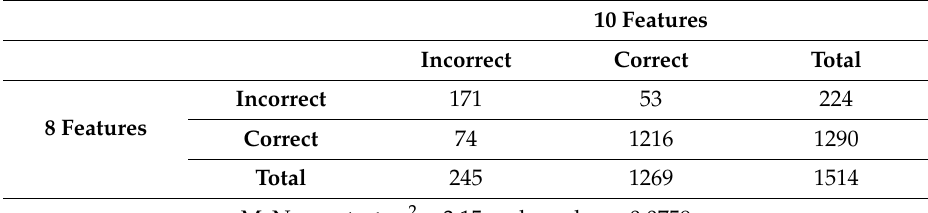
Table 6. Cross-tabulation of confusion matrices between SVM classifiers with eight and 10